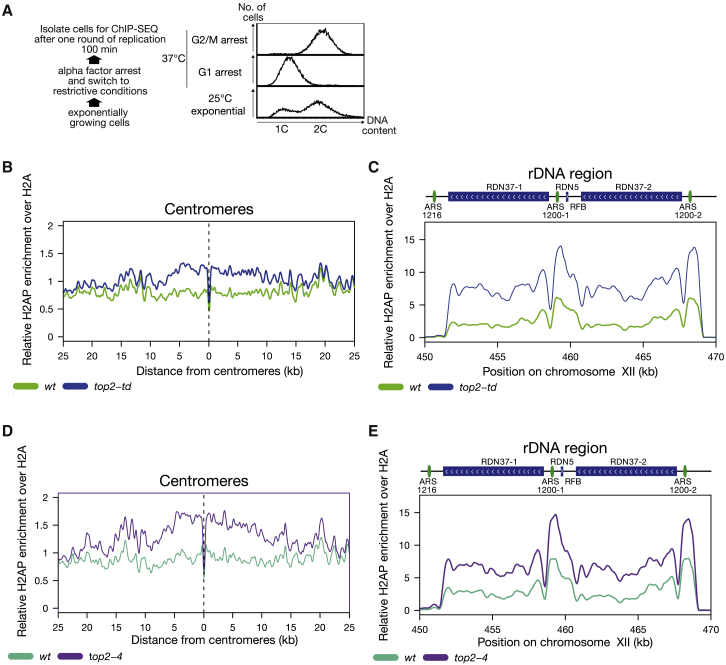
Depletion of Top2 during S Phase Causes H2AS129P Enrichment at Centromeres and over the rDNA Repeats(A) Experimental setup of ChIP-seq experiments, indicating how the post-replication cell populations used for the ChIP-seq experiments were prepared. A representative FACS analysis of DNA content of each of the indicated stages of the experiment is shown.(B) The relative enrichment of H2AS129P over H2A ChIP around centromeres in cells is shown either with wild-type expression of Top2 in parental cells (green) or depleted of Top2 (blue) in top2-td cells, both released into the cell cycle under the restrictive conditions. Graph shown is generated from a pile up of the profiles of all centromeres and is an average of two repeats.(C) The relative enrichment of H2AS129P over H2A ChIP across the rDNA repeats in cells either with wild-type expression of Top2 (green) or depleted of Top2 (blue) in top2-td cells, both released into the cell cycle under the restrictive conditions. Graph shown is an average of two repeats.(D) The relative enrichment of H2AS129P over H2A ChIP around centromeres in cells is shown either with wild-type expression of Top2 in parental cells (turquoise) or in top2-4 cells (purple), both released into the cell cycle under the restrictive conditions. Graph shown is generated from a pile up of the profiles of all centromeres and is an average of two repeats.(E) The relative enrichment of H2AS129P over H2A ChIP across the rDNA repeats in cells either with wild-type expression of Top2 in parental cells (turquoise) or in top2-4 cells (purple), both released into the cell cycle under the restrictive conditions. Graph shown is an average of two repeats.See also Figures S1, S2, and S7.